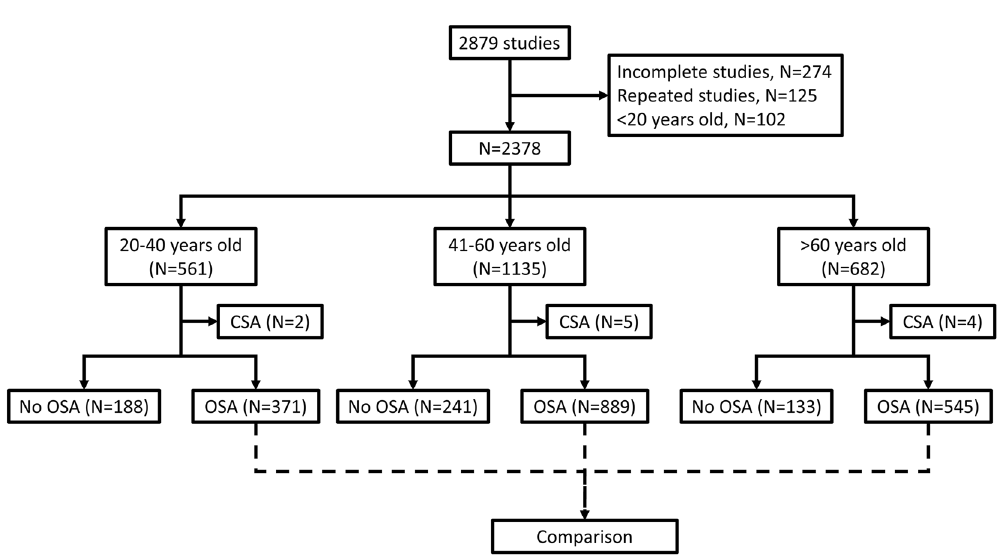
Figure 2. The flow diagram of comparison of patients with OSA across age